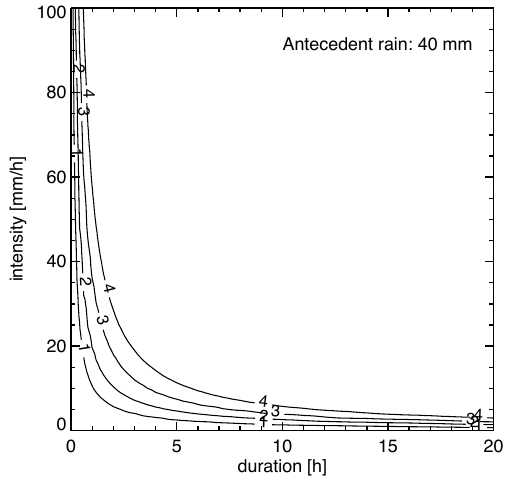
Figure 7. Example of the curves used for diagnosing the percent of subbasin unstable area based on rainfall duration and mean inten- sity. This case is for an antecedent rain of 40mm.